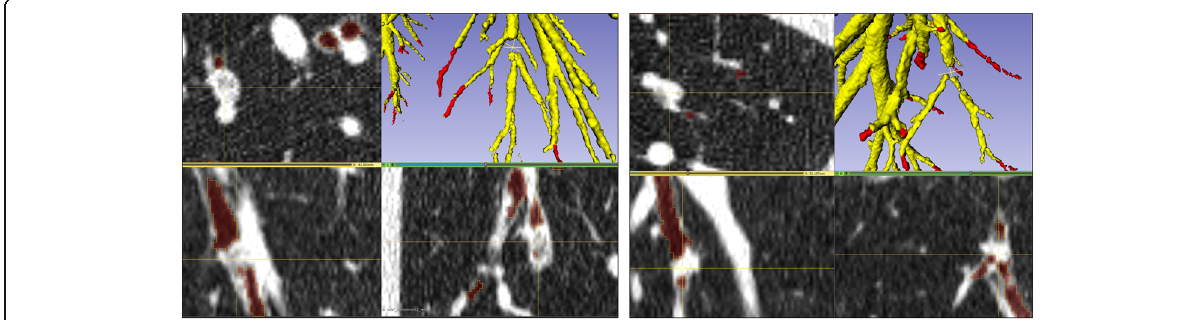
Fig. 3 Two examples of large mucous plugging with total focal occlusion of the airway of an ImaLife participant. The 3D-Unet completed segmentation of branches distal to the occlusion without